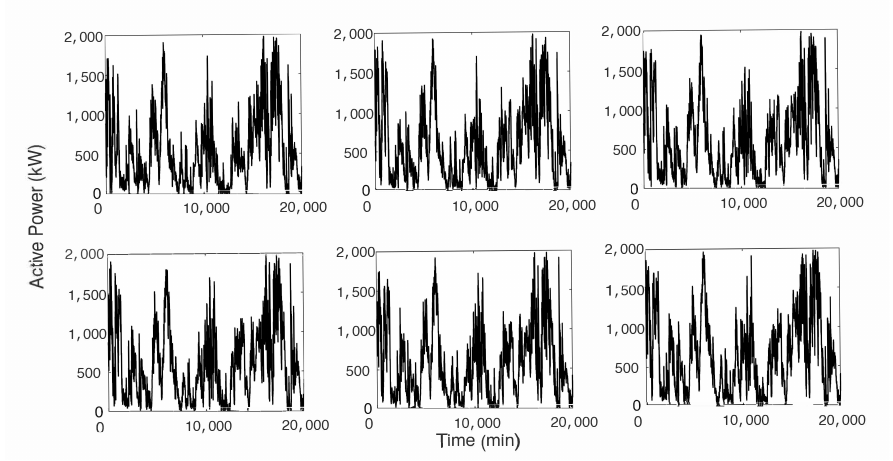
Figure 1. Sample database for each turbine.